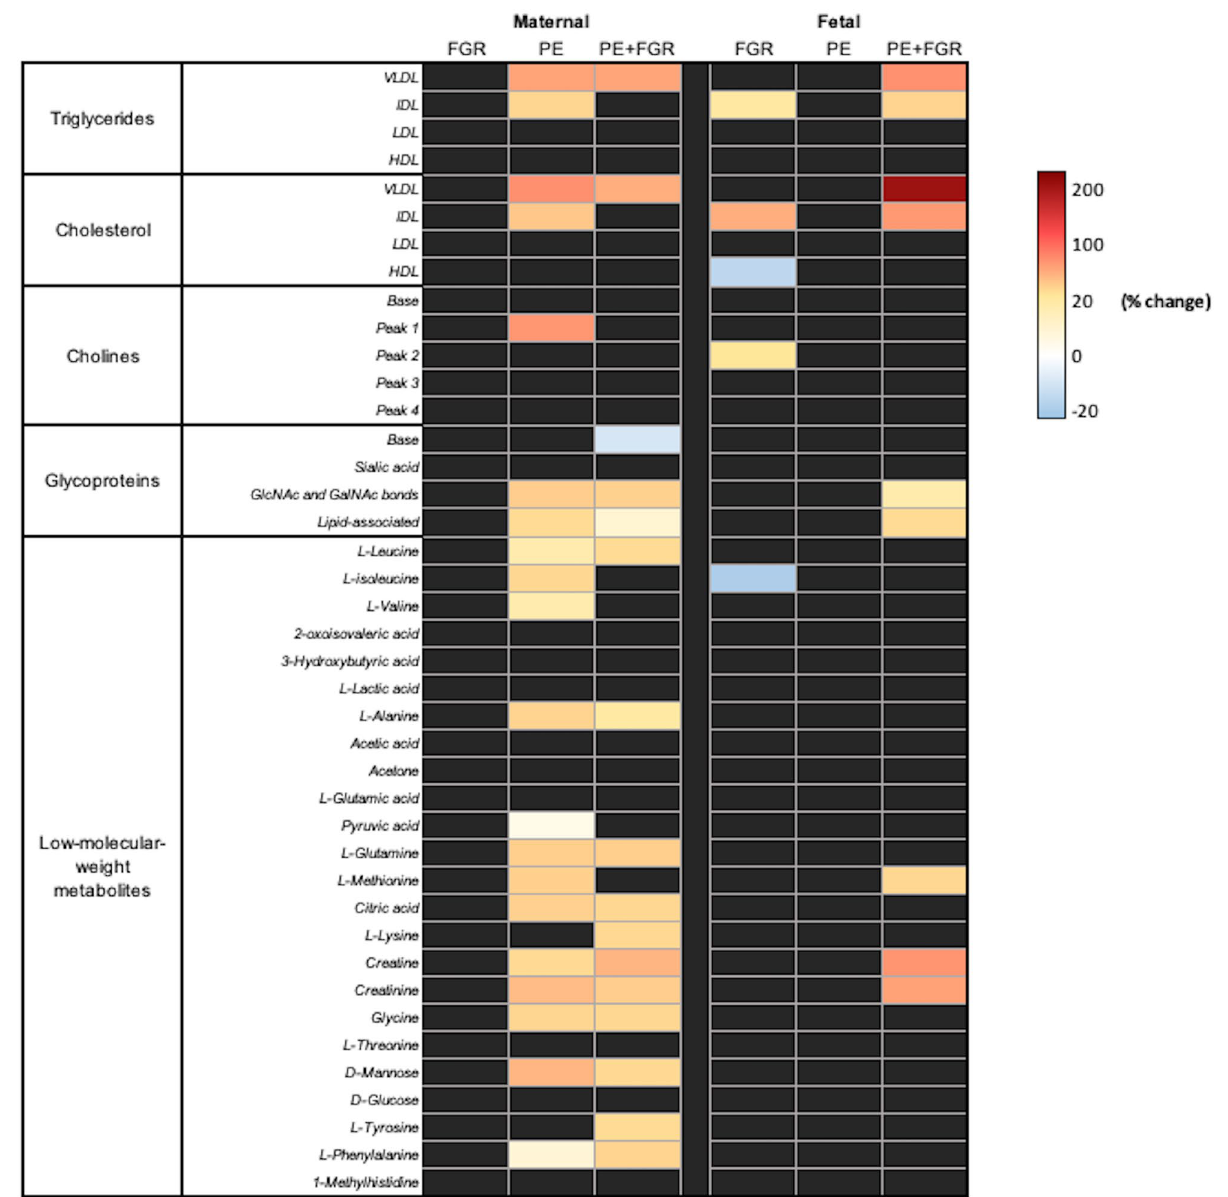
Figure 2. Metabolomic heat maps. Left-side, maternal (controls [n = 88], FGR [n = 44], PE [n = 40], PE + FGR [n = 50]); right-side, cord blood (controls [n = 86], FGR [n = 43], PE [n = 37], PE + FGR [n = 50]) plasma samples. The colored heat map represent the percentage change of the metabolite medians for cases versus controls, following a graded color scale from blue (− 20%) to yellow (+ 20%), to red (+ 200%). Only significant changes are displayed, according to the Mann Whitney U test and confirmed by linear regression adjustment for maternal body mass index, smoking, sample collection date, gestational age at delivery/sampling, route of delivery and fetal gender after 5% false discovery rate correction (Supplementary Table S1). FGR, fetal growth restriction; PE, preeclampsia; VLDL, Very low-density lipoprotein; IDL, Intermediate-density lipoprotein; LDL, Low-density lipoprotein; HDL, High-density lipoprotein; Glc/GalNAc, N-acetylglucosamine and N-acetylgalactosamine